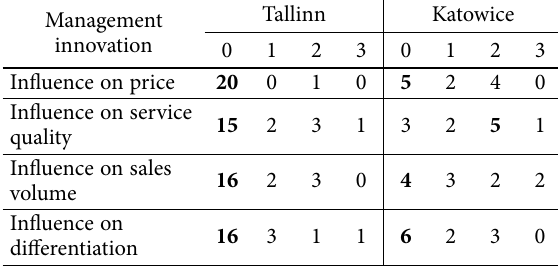
Table 2. Air cargo service providers distribution by perceived Table 7. Marketing innovation influences in the air cargo innovation levels in own company (in last two years) Tallinn Types of innovation